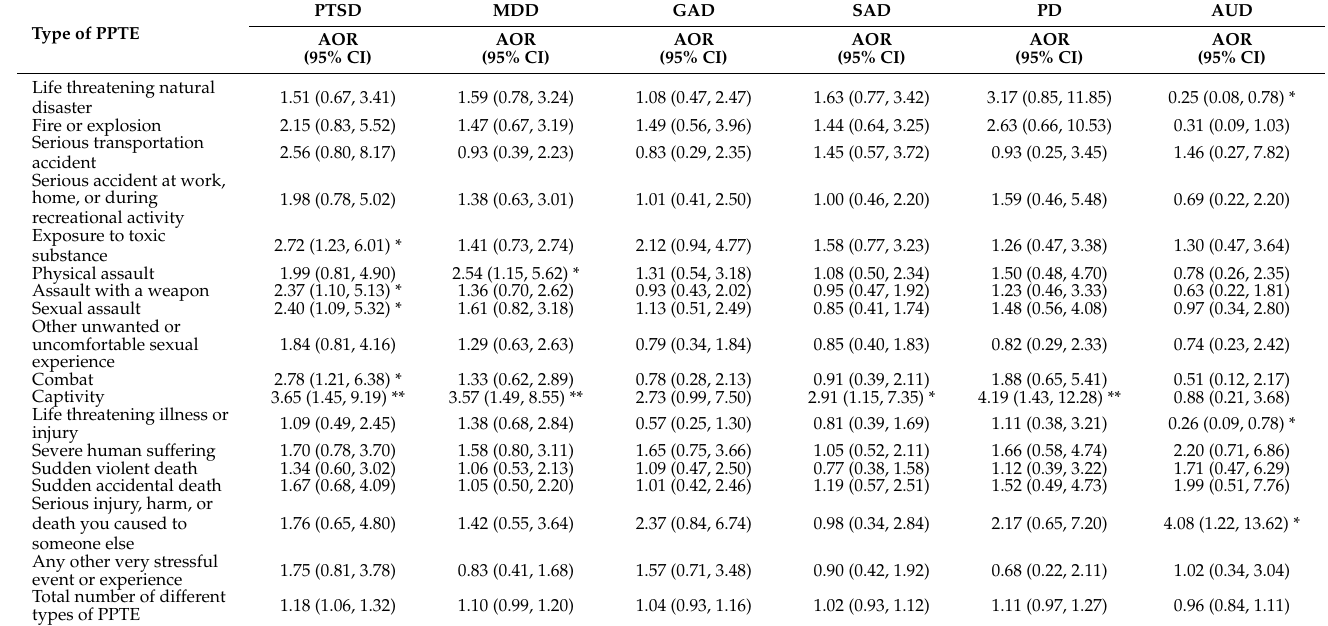
Table 6. Associations Between Potentially Psychologically Traumatic Events (PPTEs) Exposure and Screening Positive for Mental Disorders, Canadian Coast Guard (CCG) Sample (Adjusted for Sociodemographics).